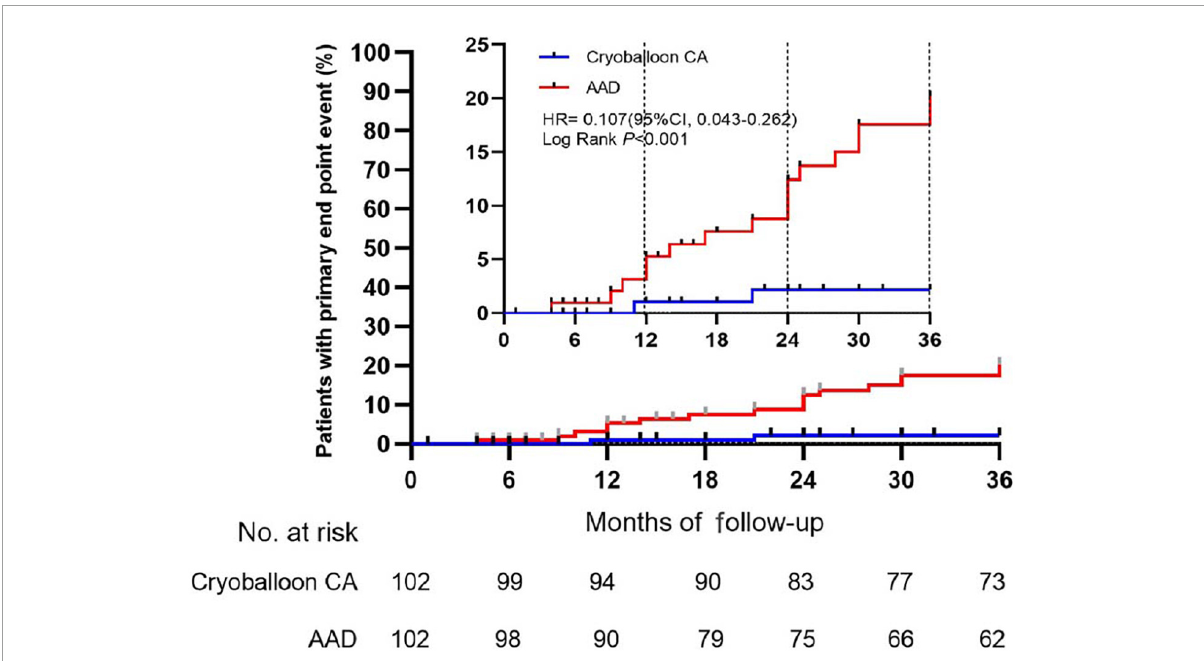
FIGURE2 Time to the occurrence of persistent atrial tachyarrhythmia in the intention-to-treat cohort. CA, catheter ablation; AAD, anti-arrhythmic